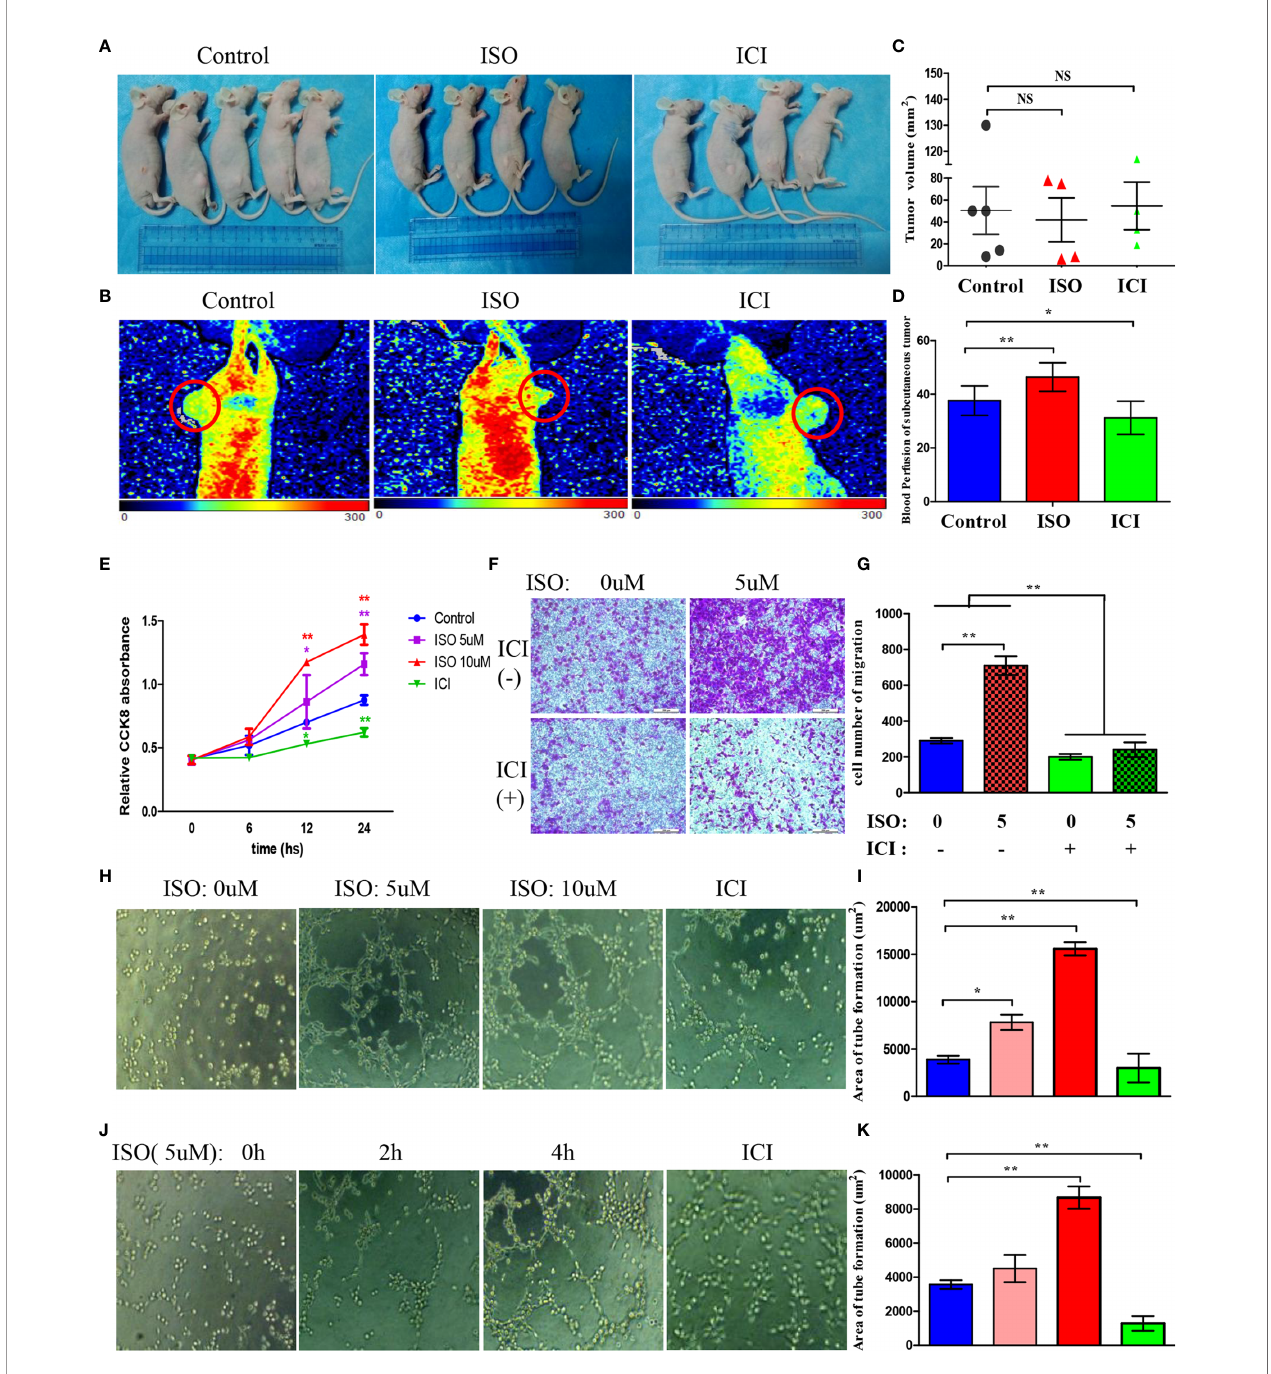
FIGURE 2 | Isoprenaline promotes tumour angiogenesis in vivo and in vitro . (A) MGC803 cells used for subcutaneous tumour inoculation into BALB/c nude mice. ISO and ICI treatments of mice. (B) Representative pictures of blood perfusion in BALB/c nude mice are shown, and the blood perfusion at the tumor growth site is circled in red. (C) The volume of xenografts is shown. (D) The data of the recorded ROI perfusion values. (Control group, n = 5; ISO group, n = 4; ICI group, n = 4) (E) Effects of ISO and ICI on HUVECs proliferative ability. (F) Representative photographs of migration are shown in each panel. (G) Cells were counted in random fi ve fi elds, and quantitative analysis is presented in every panel. (H) HUVECs were treated with 0, 5 or 10 m M ISO and 10 m M ICI within Matrigel-coated 96-well plate. (J) HUVECs were treated with 5 m M ISO for 0, 2, 4h and 10 m M ICI within Matrigel-coated 96-well plate. (I, K) Quantitative analysis of tube formation in random fi ve fi elds is shown. Data represent mean± SD (NS, No Signi fi cance; *P < 0.05, **P <